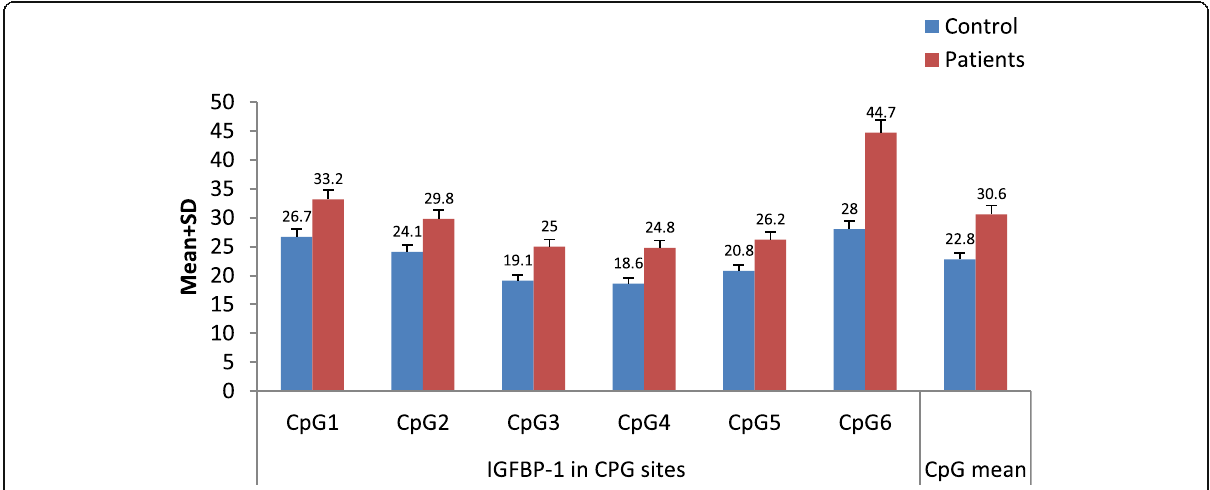
Fig. 1 Comparison of the IGFBP-1 DNA methylation level in six CPG sites between the studied groups